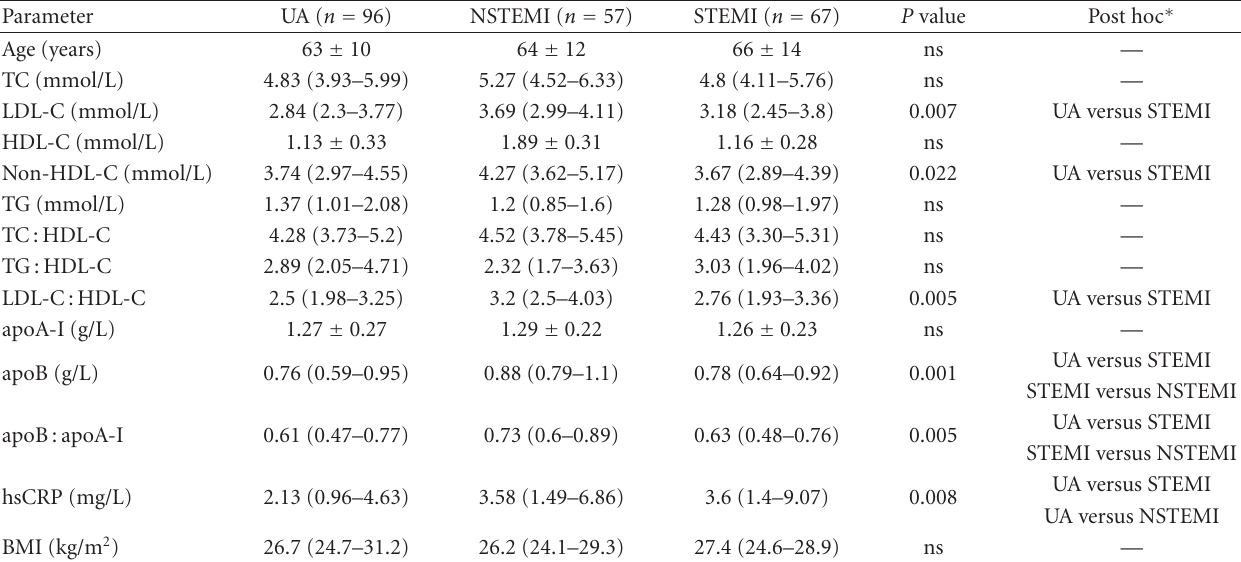
Table 2: Characteristics of patients according to the type of ACS.